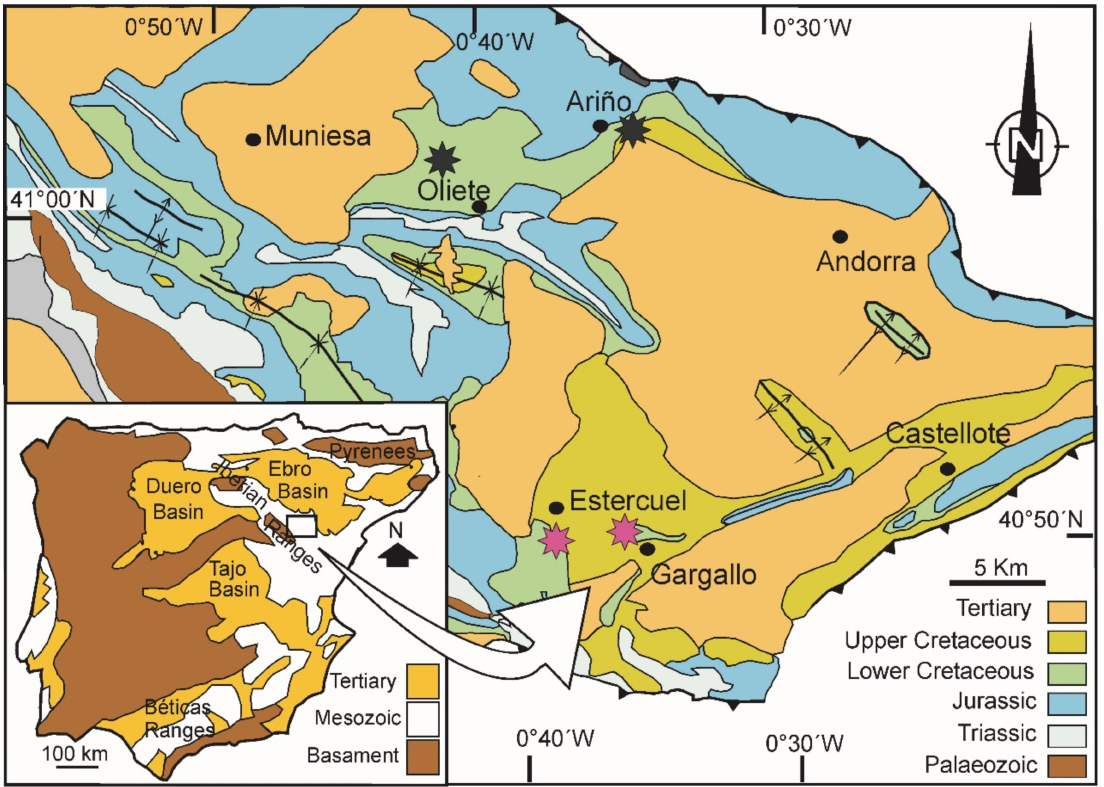
Figure 1. Ball clay deposits located and studied in the Iberian Range (Oliete Basin, NE Iberian Peninsula (blue stars: Bauluz et al., (2008) [12], red stars: this